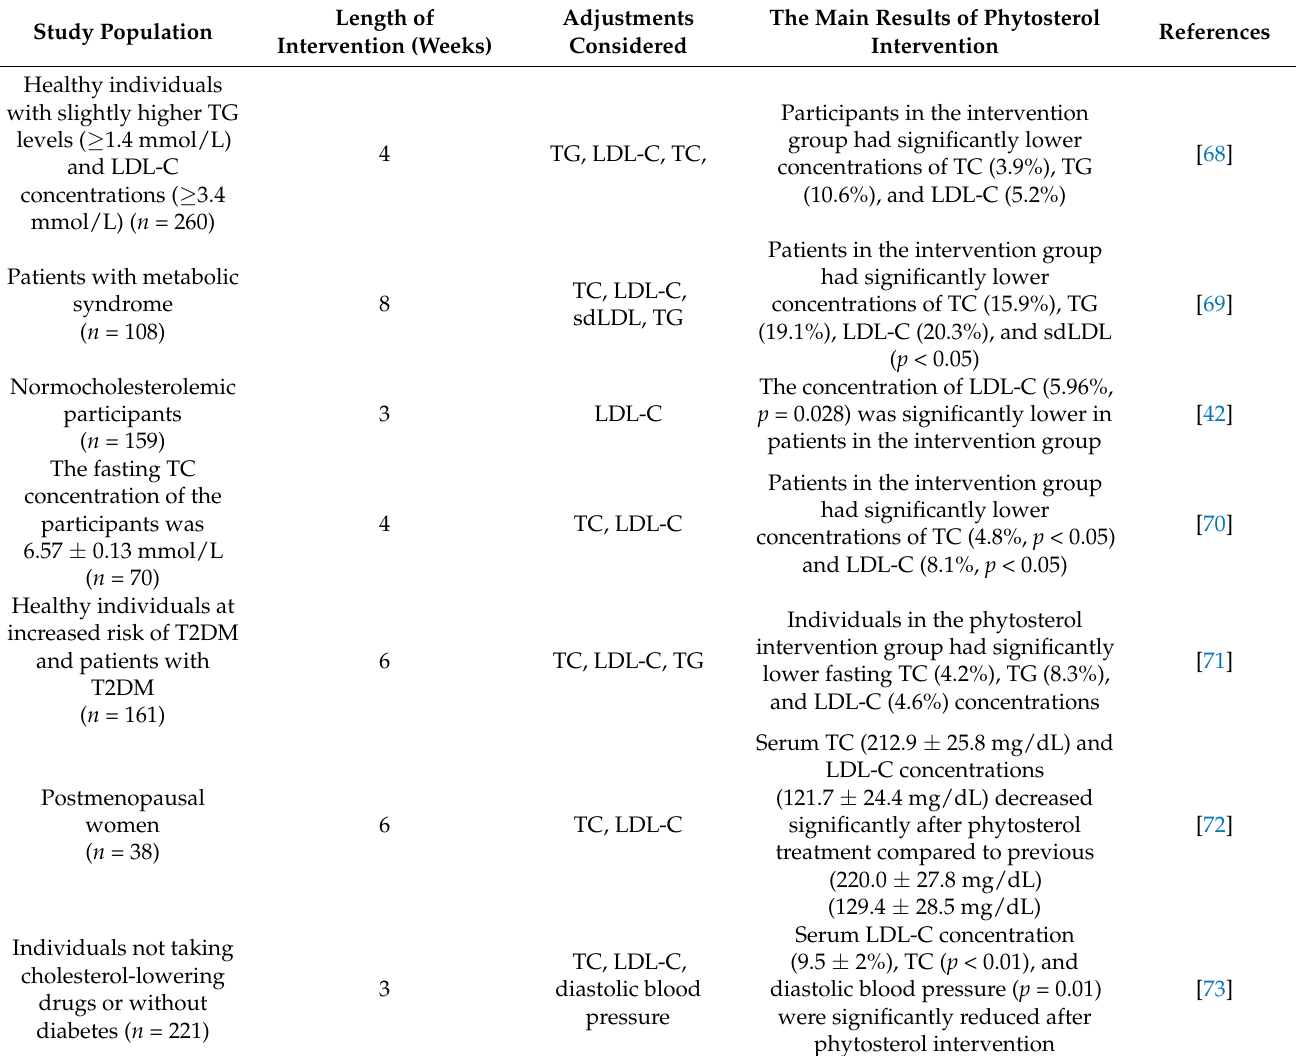
Table 1. Cholesterol-reducing potentials of phytosterols in clinical